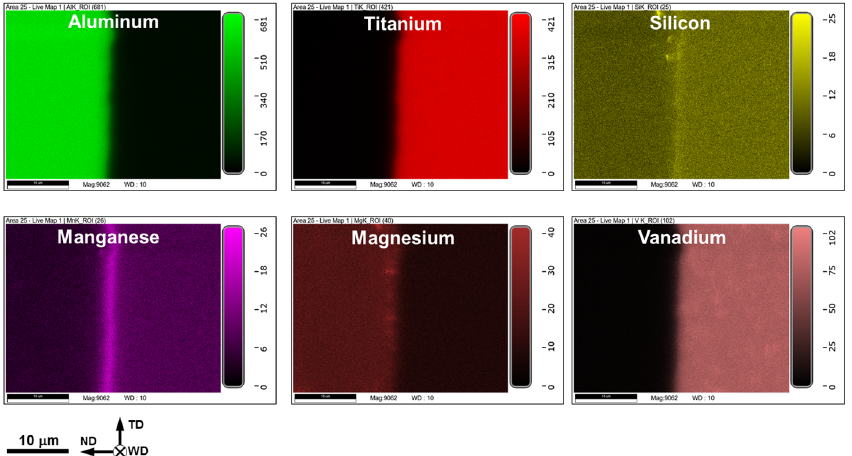
Figure 5. Typical results of quantitative EDS analysis of intermetallic layer. ND, TD, and WD are normal direction, transverse direction, and welding direction, respectively. Note: The EDS data were taken from the welded joint AA6013 alloy produced at the welding speed of 12.7 mm/min.